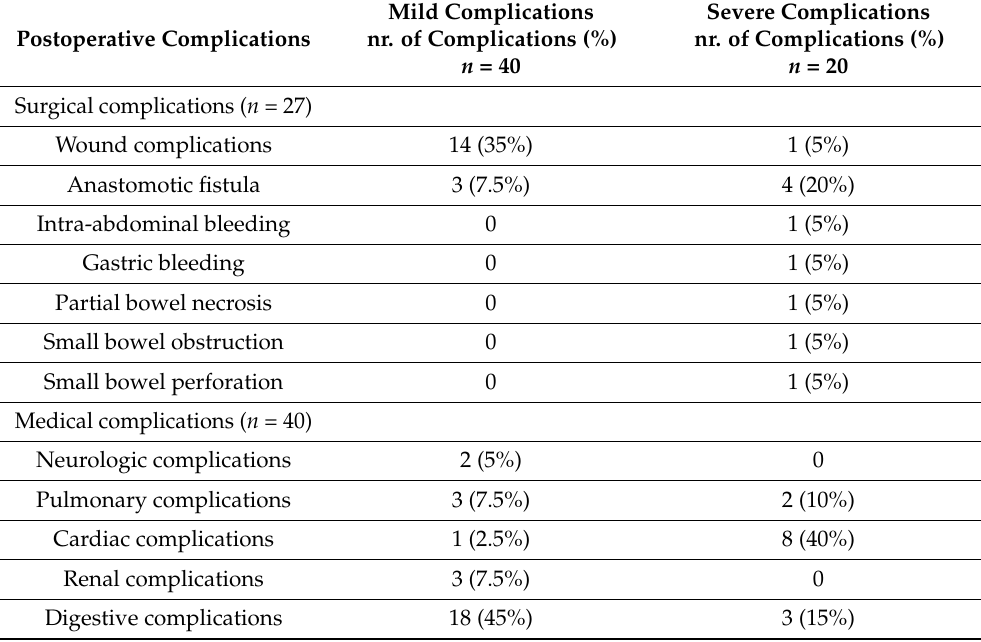
Table 1. Postoperative complications according to Clavien–Dindo